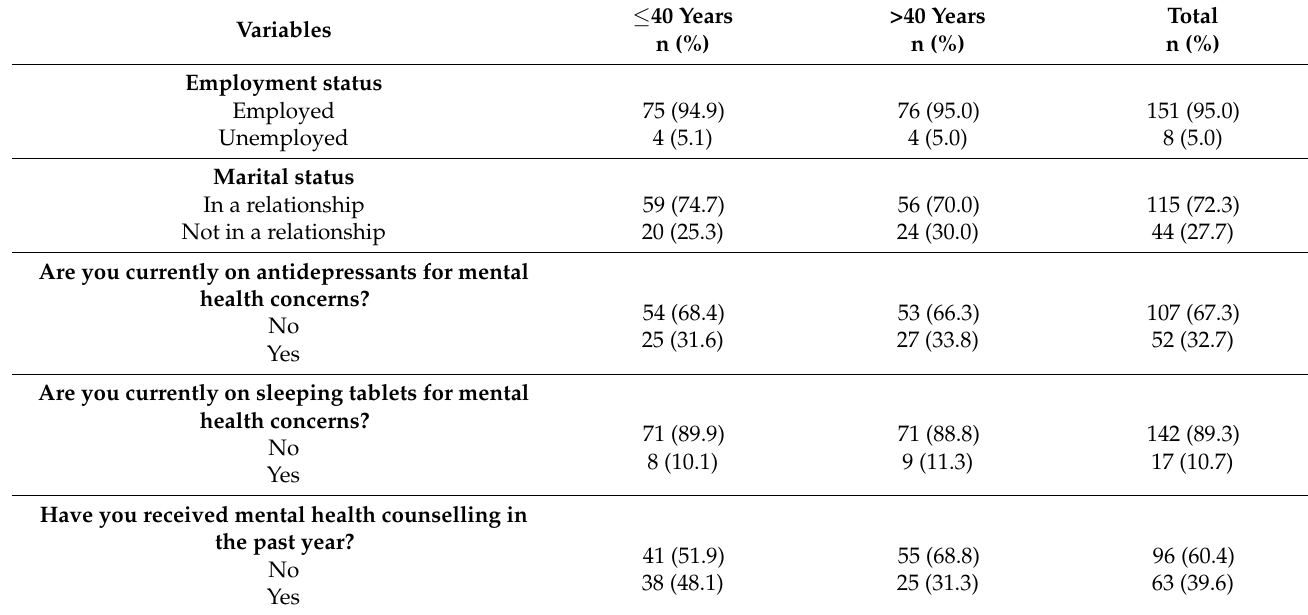
Table 1. Age distribution of sociodemographic and clinical